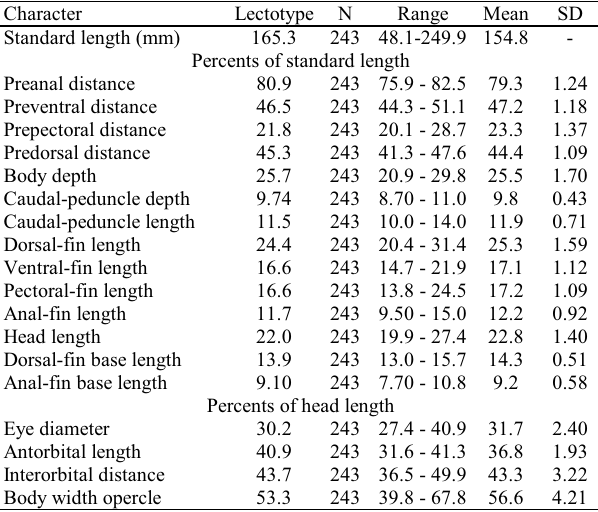
Table 5. Morphometrics of Laemolyta proxima